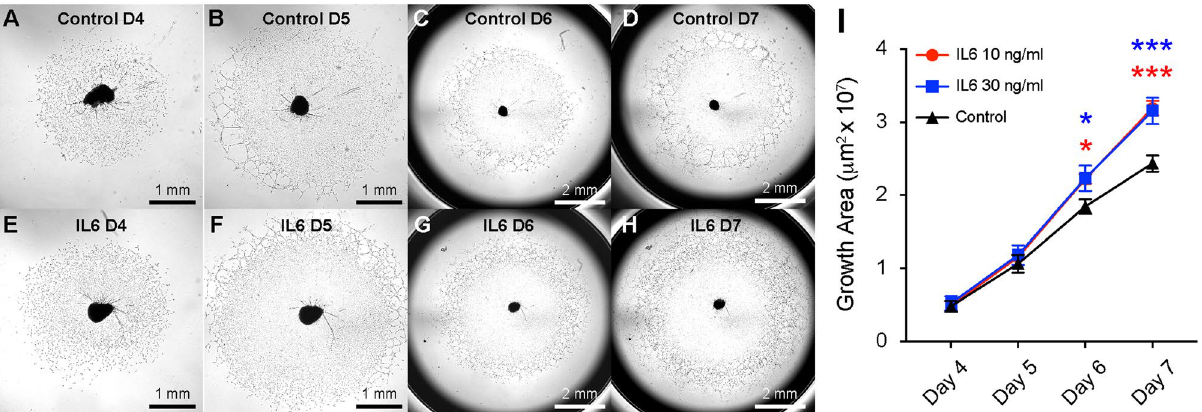
Figure 3. IL6 is sufficient for choroidal angiogenesis. Representative phase contrast brightfield microscopy of choroidal sprouts from control ( A – D ) and IL6 ( E – H ) treatment on Days 4 – 7. Exogenous IL6 treatment ( I ) increased choroidal angiogenesis area by 1.2 fold (* = p < 0.05, N = 5 per group) on Day 6 (D6) and 1.3 fold (*** = p < 0.001) on Day 7